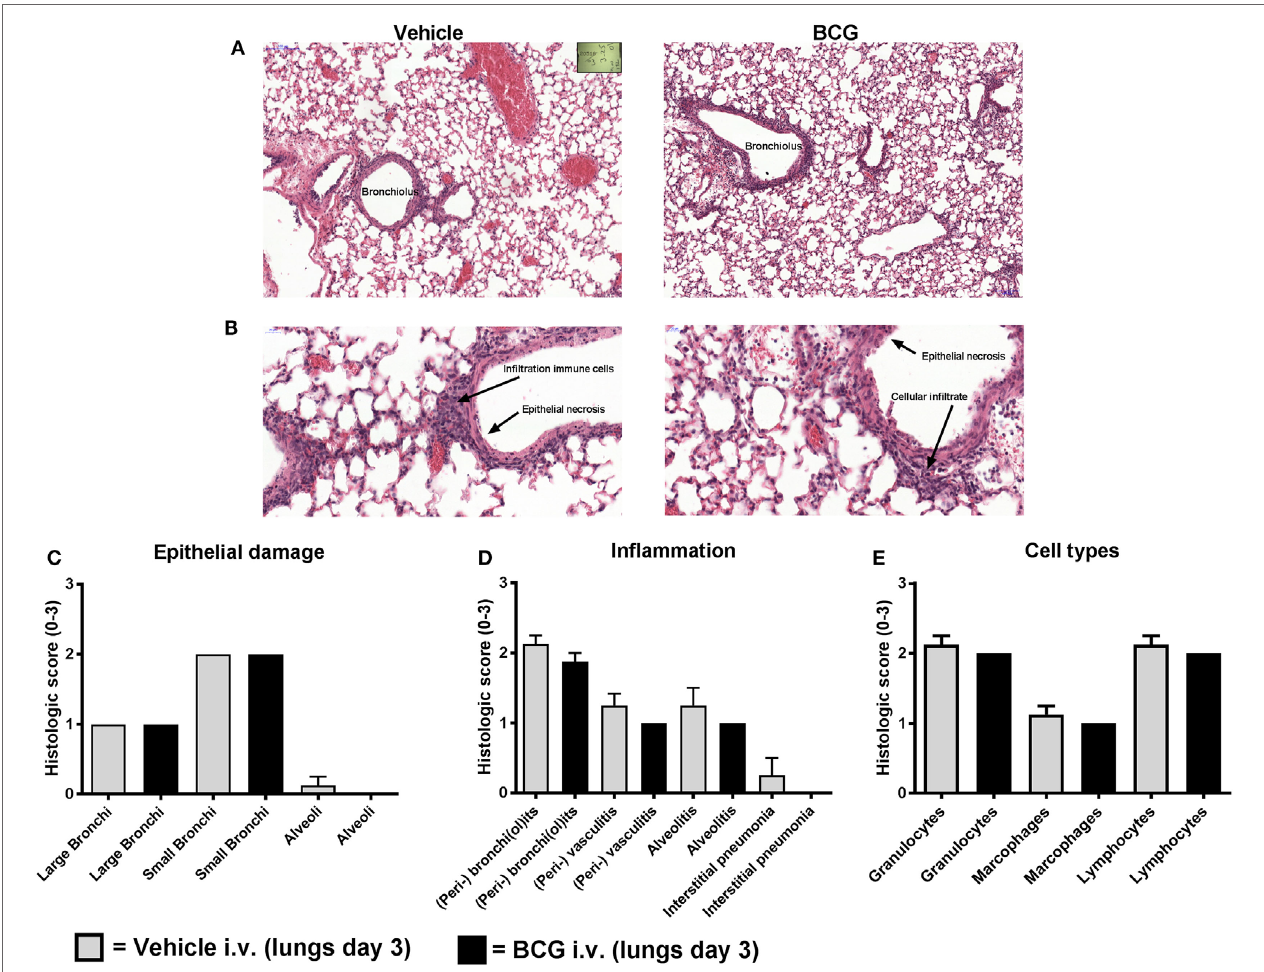
FigUre 5 | Bacillus Calmette–Guérin (BCG) vaccination does not lead to reduction of histopathological damage and inflammation. Female BALB/c mice were challenged with a dose of 4MLD 50 influenza A/Anhui/1/2013 (H7N9) on day 0. Mice received 750 µg BCG or vehicle control (phosphate buffered saline) i.v. on day –7 ( n = 8 per group). Three days after viral challenge, lungs were fixed in formalin. Paraffin-embedded tissue sections were then stained for hematoxylin and eosin. Representative histopathological image of vehicle versus BCG-treated mice are depicted (a,B) . Lung sections were scored from absent to marked: score “0” (absent), score “1” (minimal), score “2” (moderate), and score “3” (marked) for epithelial necrosis (damage) (c) , inflammation markers (D) , and inflammatory cell types (e) . Results were statistically analyzed using the Cochran–Mantel–Haenszel test. Data are shown as mean ±